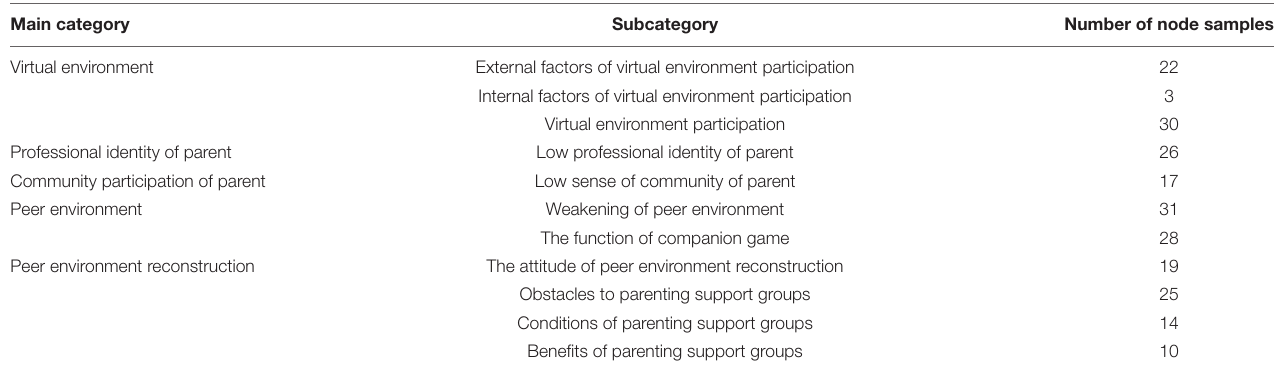
TABLE 1 | Main categories and subcategories developed from axial coding to selective